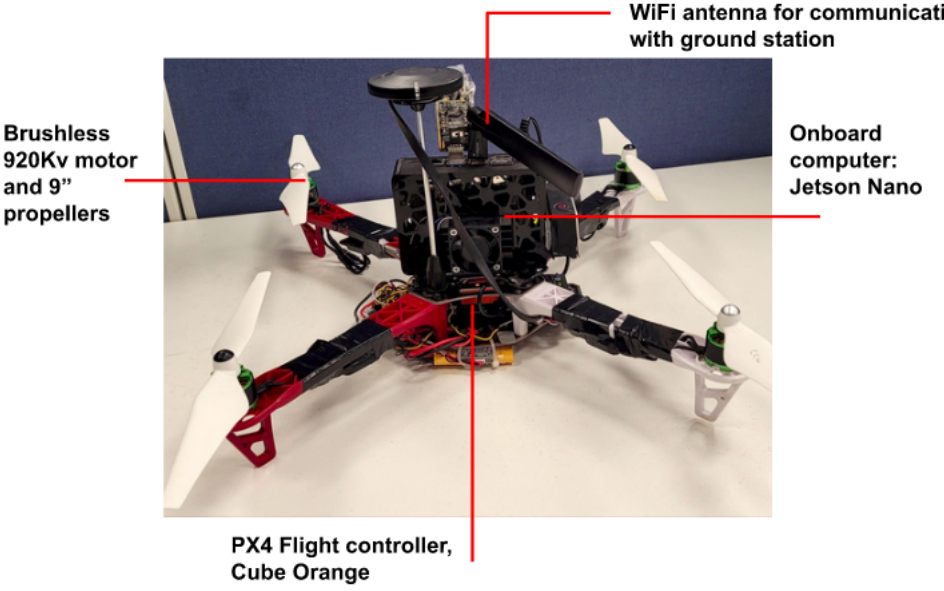
Figure 10. F450 quadcopter platform used in the OCTUNE hardware